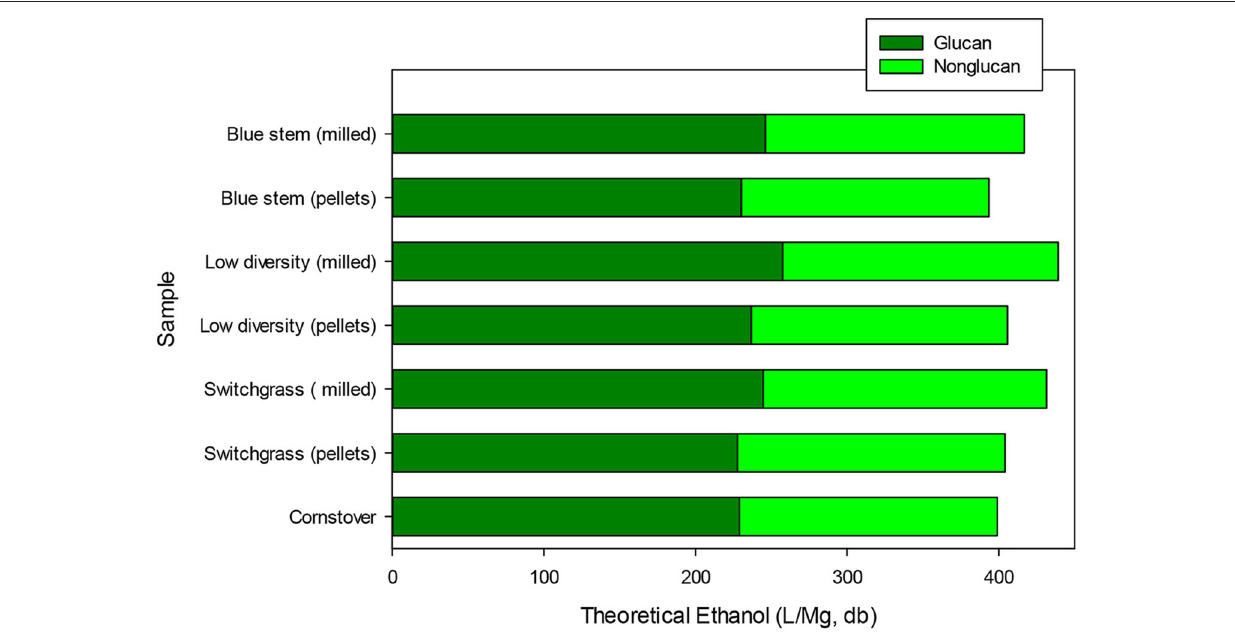
ASL c Soluble Starch Extractable Sum lignin b sugars